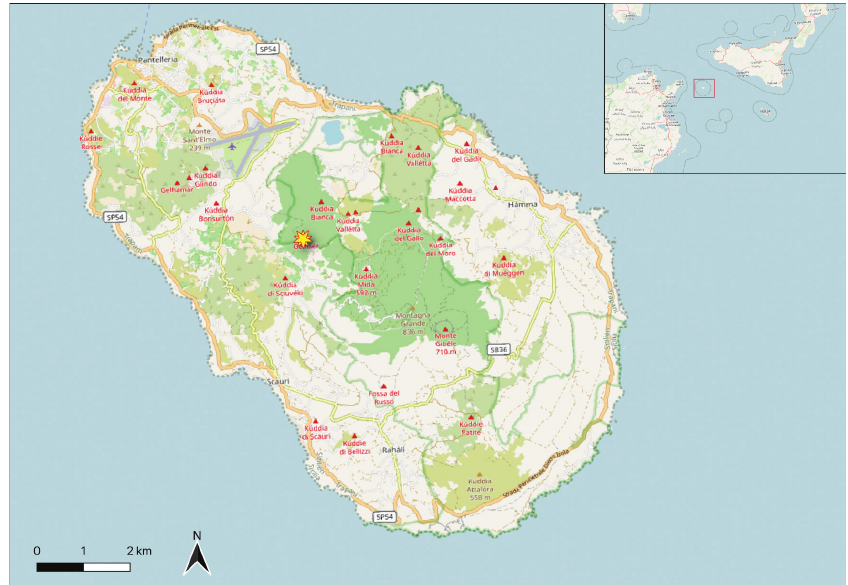
Figure 2. Geographic range and distribution map of Limonium parvifolium (Tineo) Pignatti in Pantel- leria